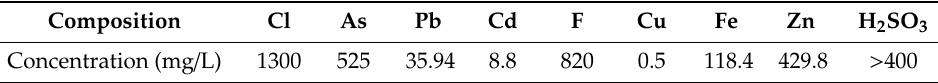
Table 1. The elemental composition of waste acid samples in this study.